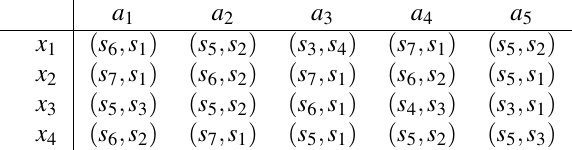
Table 3. Decision matrix R 3